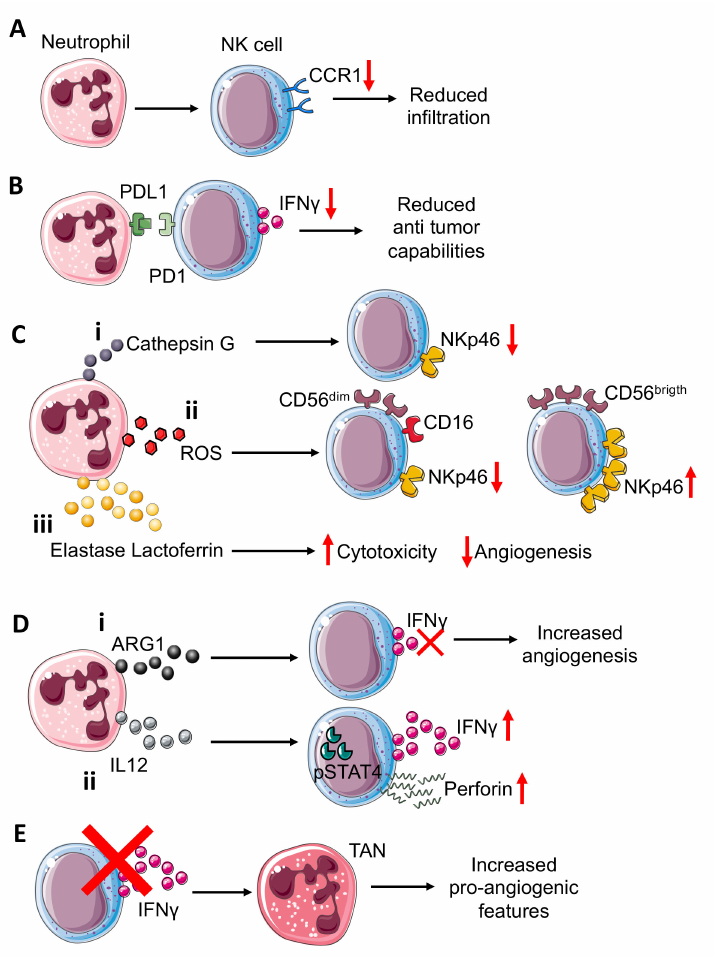
Figure 2. Neutrophil–NK cell crosstalk in tumor microenvironment . Neutrophils can ( A ) induce reduction in CCR1 expression on NK cells, impairing the NK cells’ infiltration capability.